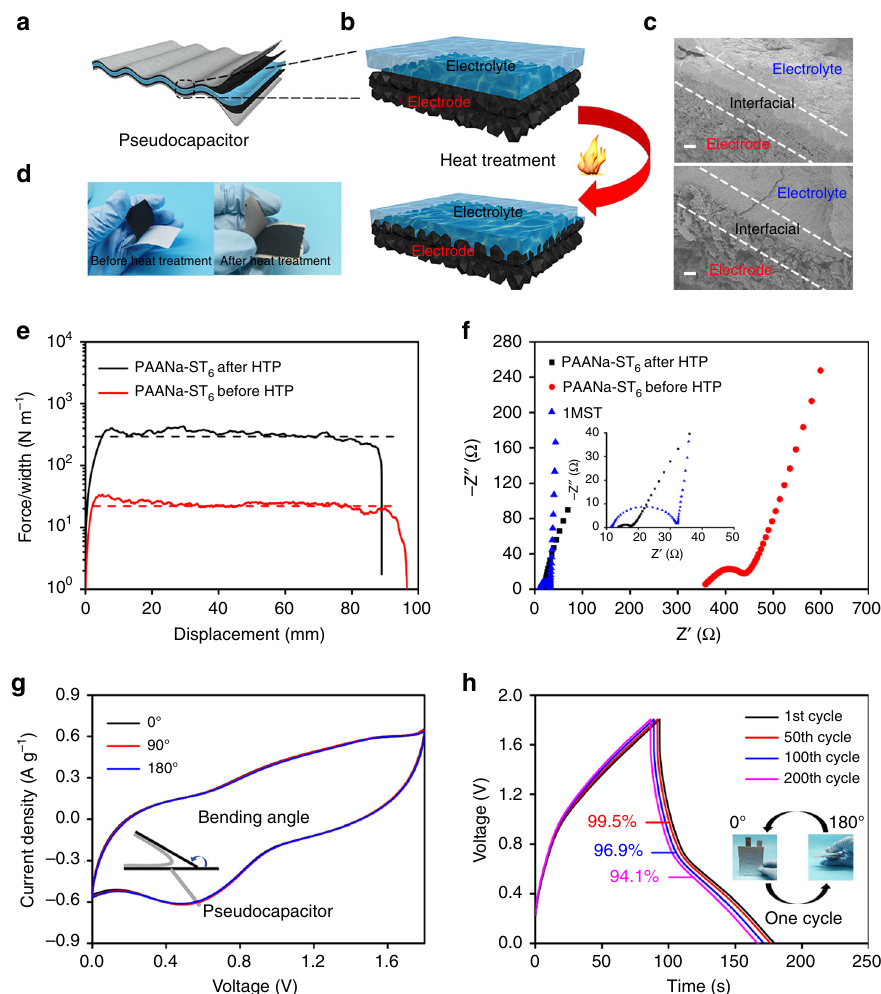
Fig. 5 Measurement of electrode – electrolyte interface. a Schematic diagram of a fl exible capacitor containing active material, current collector, and electrolyte. b Electrode – electrolyte interface bonding diagram before (upper panel) and after (lower panel) heat treatment. c Scanning electron microscope of the interface between electrode and electrolyte in the capacitor before (upper panel) and after (lower panel) heat treatment. Scale bar, 20 μ m. d Optical image of the interface between electrode and electrolyte in the fl exible capacitor before and after heat treatment. e Curves of peeling force per width of the PAANa-ST 6 sheet and carbon cloth sheet. f Nyquist plots of the supercapacitors with different state electrolytes. g Cyclic voltammetry curves of the PAANa-ST 6 -based supercapacitor at different bending angles. h Galvanostatic charge – discharge curves of the PAANa-ST 6 -based supercapacitor after different bending